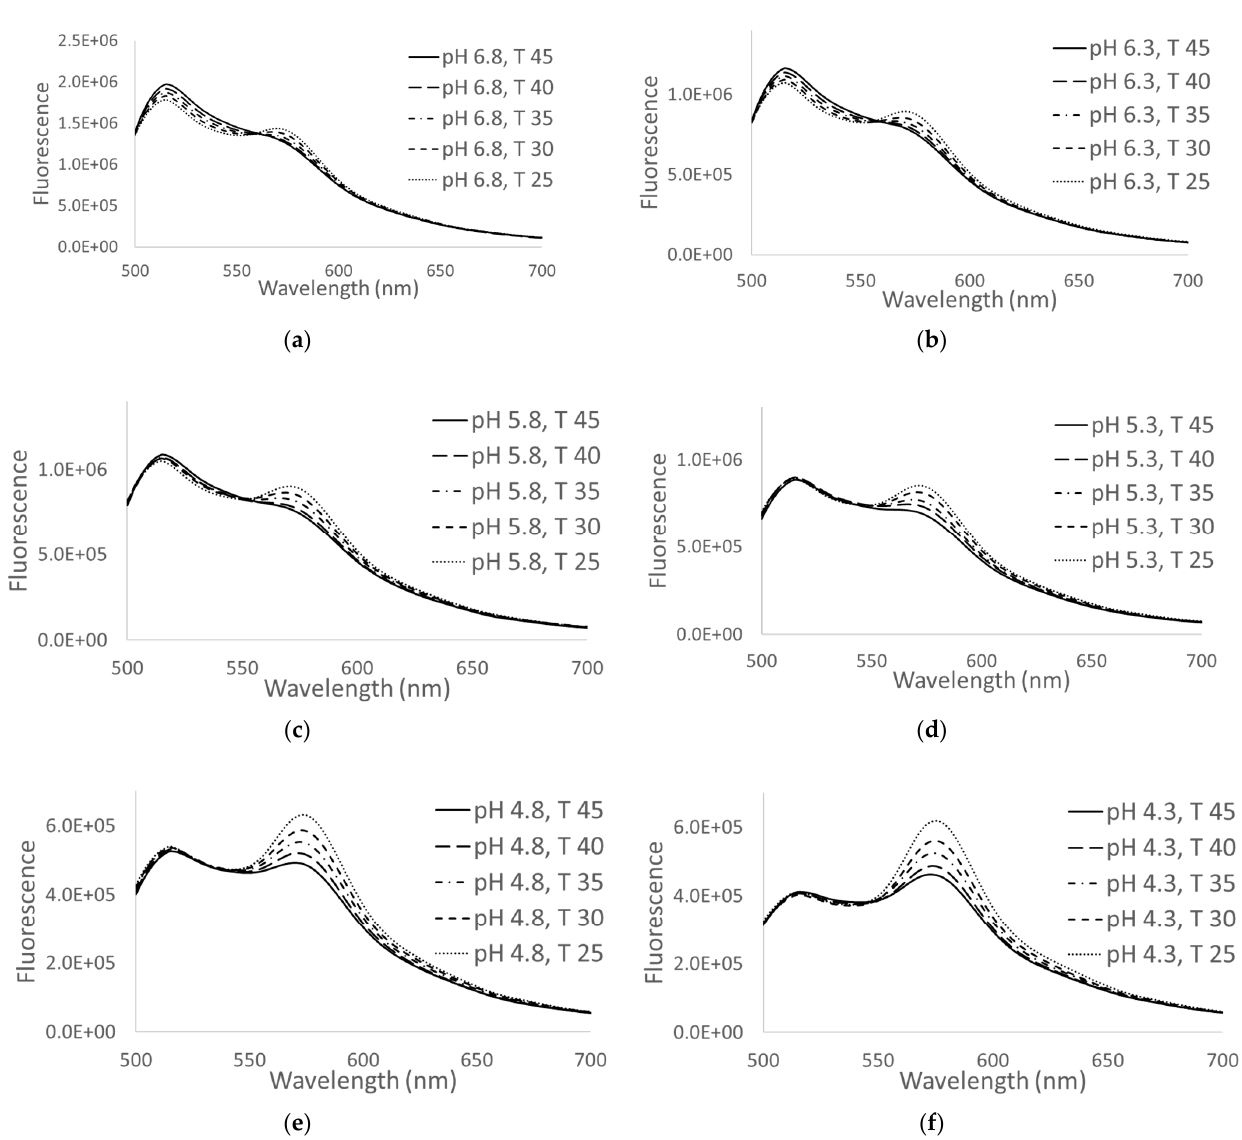
Figure 4. Temperature and pH responses of nanosensors to the change in temperature (shown for 25, 30, 35, 40 and 45 °C and the change in pH: ( a ) 6.8, ( b ) 6.3, ( c ) 5.8, ( d ) 5.3, ( e ) 4.8 and ( f ) 4.3, respectively. The excitation wavelength is 488 nm.